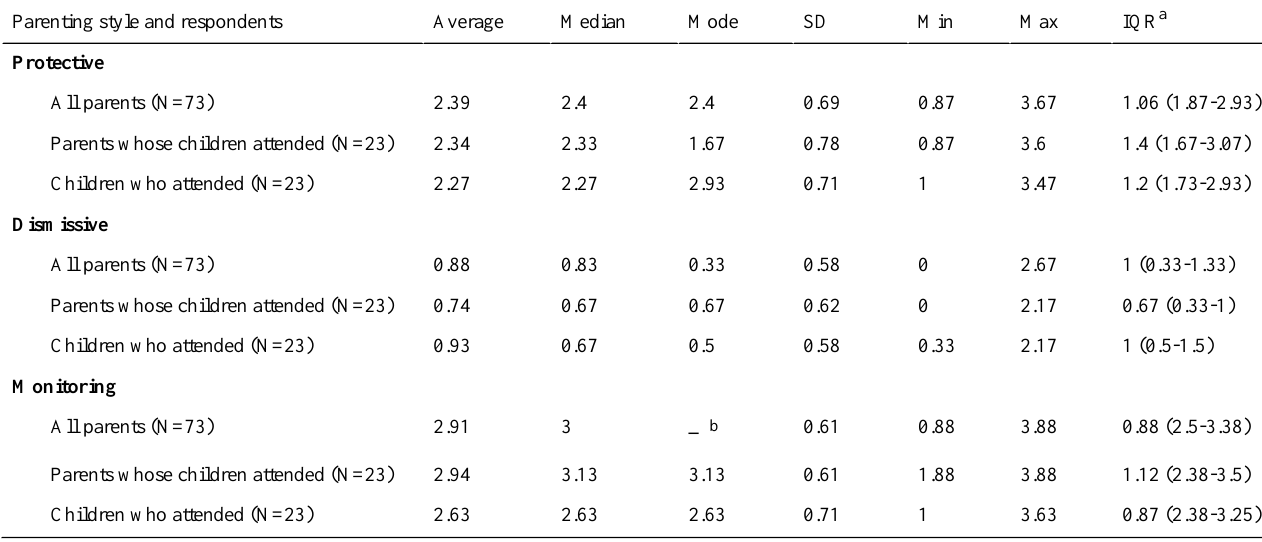
Table 8. Parenting styles as assessed by the Adult Responses to Children’s Symptoms questionnaires answered by parents and their children.